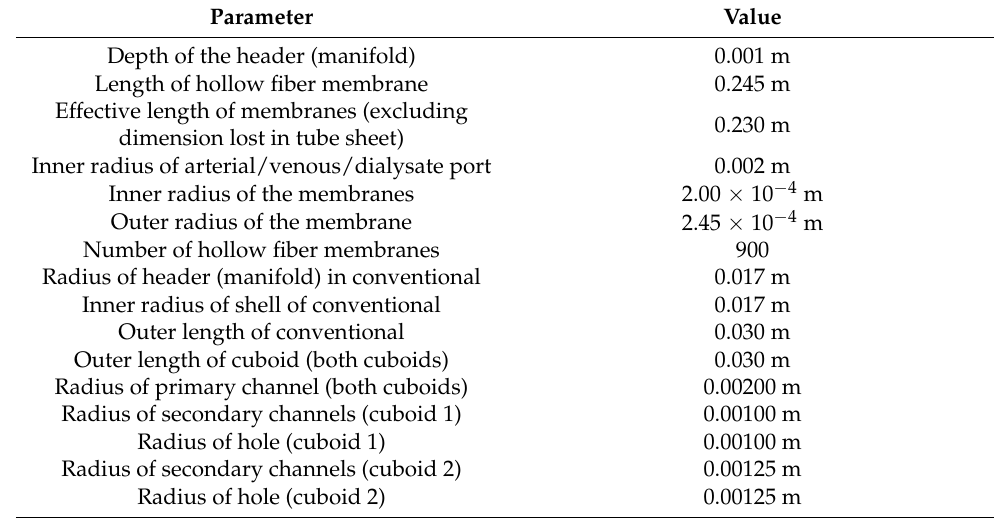
Table 1. Design information for hemodialyzers used in the CFD simulation study. Parameter Value Depth of the header (manifold) 0.001 m Length of hollow fiber membrane 0.245 m Effective length of membranes (excluding 0.230 m dimension lost in tube sheet) Inner radius of arterial/venous/dialysate port 0.002 m Inner radius of the membranes 2.00 × 10 − 4 m Outer radius of the membrane 2.45 × 10 − 4 m Number of hollow fiber membranes 900 Radius of header (manifold) in conventional 0.017 m Inner radius of shell of conventional 0.017 m Outer length of conventional 0.030 m Outer length of cuboid (both cuboids) 0.030 m Radius of primary channel (both cuboids) 0.00200 m Radius of secondary channels (cuboid 1) 0.00100 m Radius of hole (cuboid 1) 0.00100 m Radius of secondary channels (cuboid 2) 0.00125 m Radius of hole (cuboid 2) 0.00125